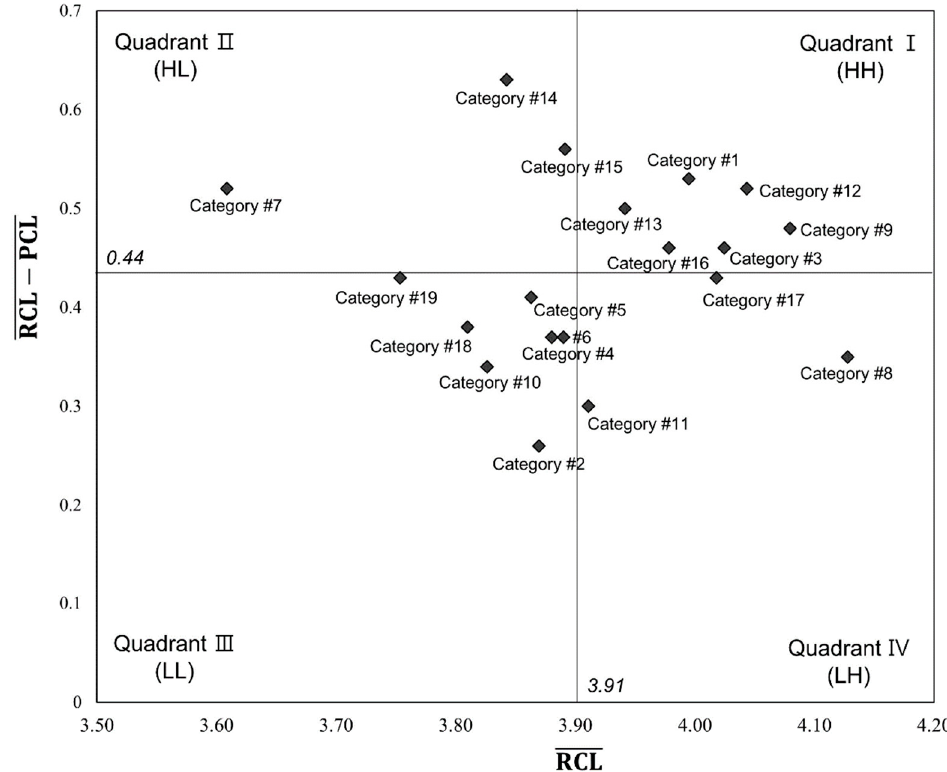
Figure 2. The LF model of home visit nursing.